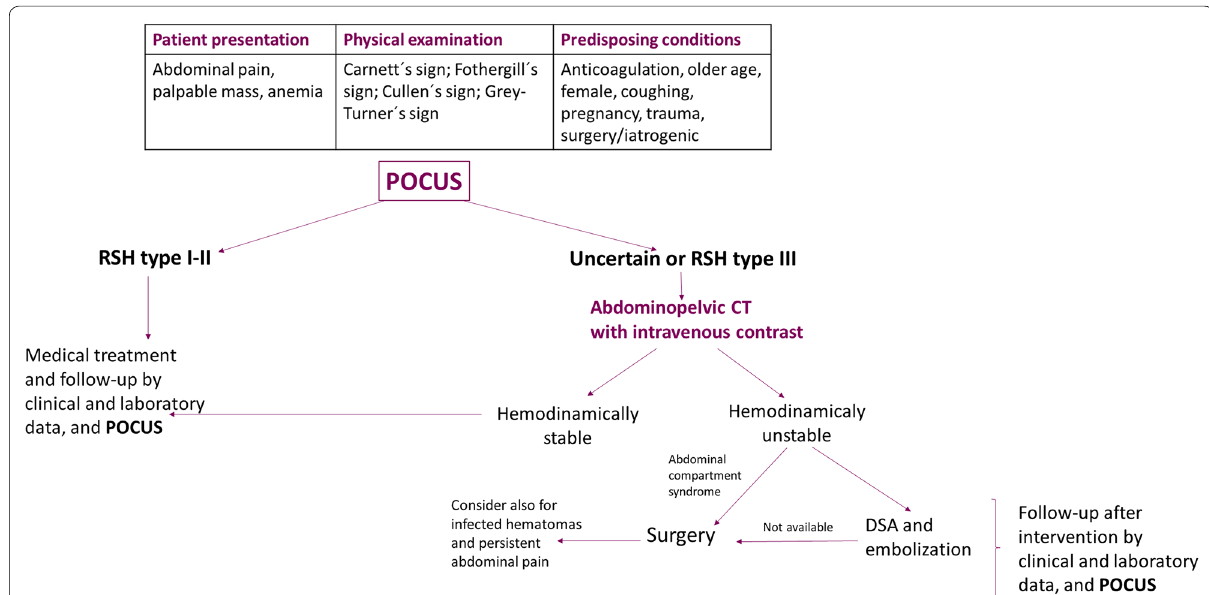
Fig. 4 Algorithm for diagnosing and managing a patient with an RSH. Modified from [2, 5]; RSH, rectus sheath hematoma; POCUS, point-of-care ultrasound; CT, computed tomography; DSA, digital subtraction